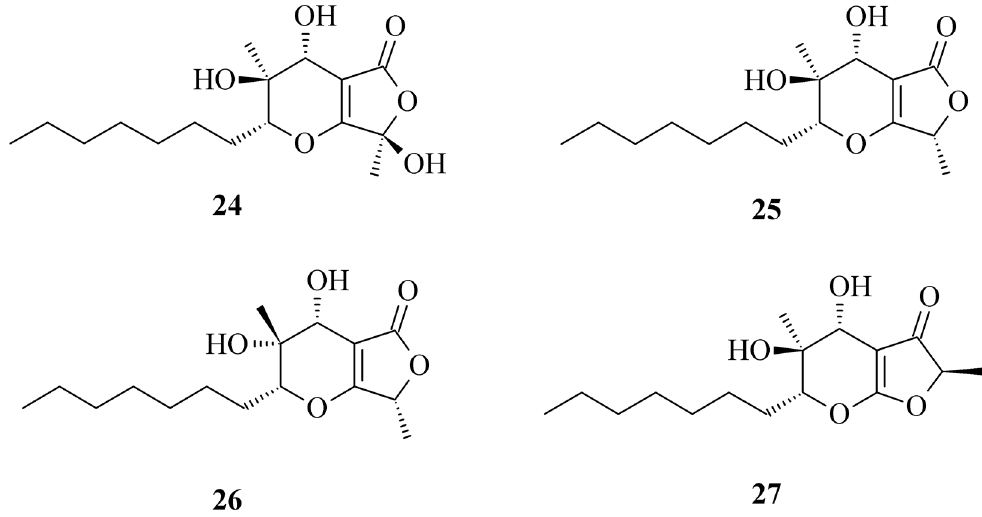
Figure 9 - New isoaigialones ( 24 , 25 and 26 ) and aigialone ( 27 ) isolated from Phaeoacremonium